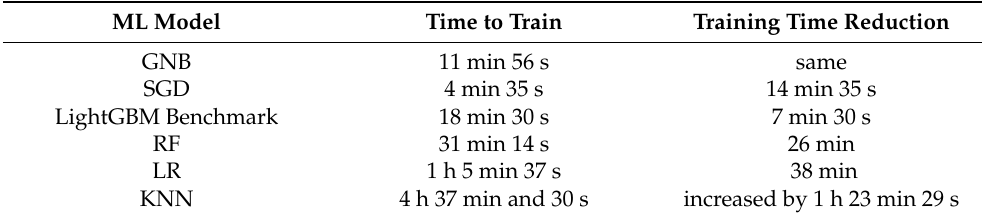
Table 6. Completion Time Results for Selected ML Models with AHBO-TPE (Ember